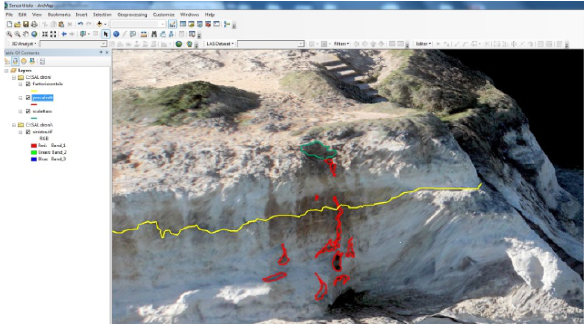
Figure 8. 3D point cloud